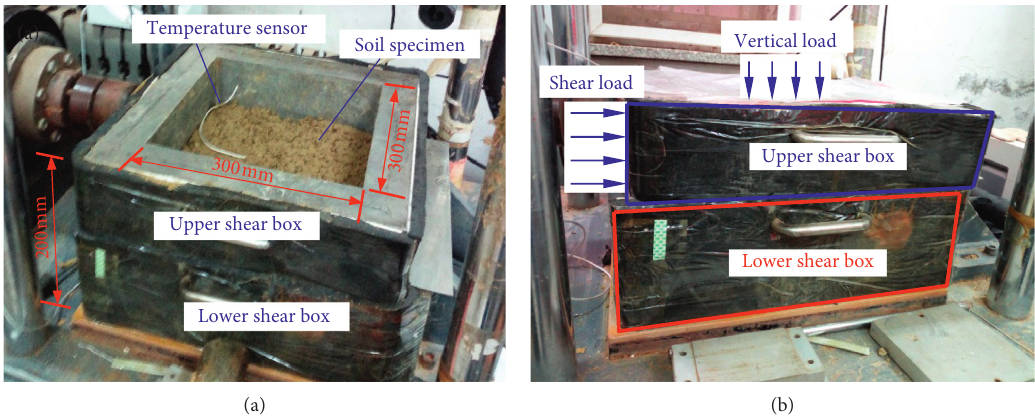
Figure 4: The specimen preparation and shear box. (a) Soil specimen preparation. (b) Shear box after direct shear